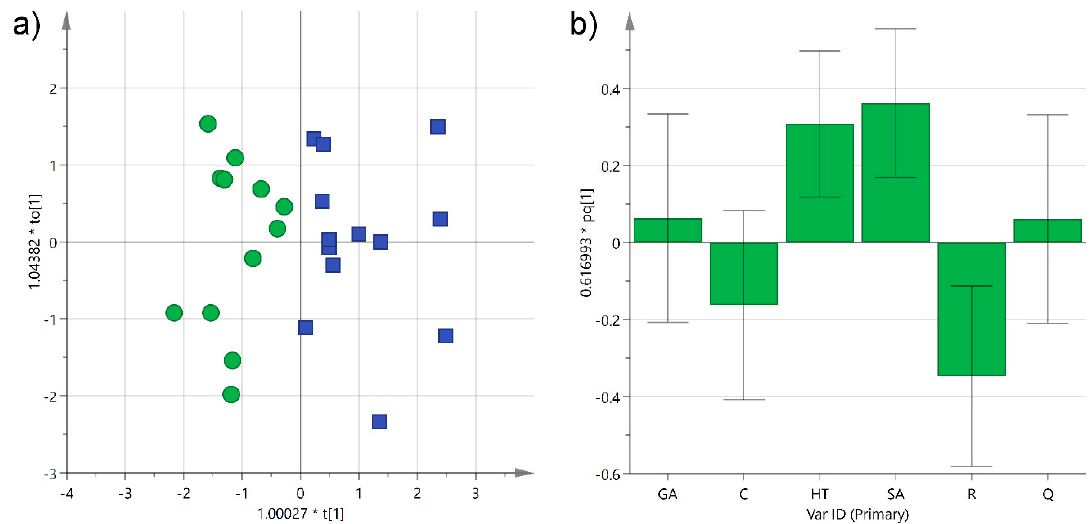
Figure 6. ( a ) Orthogonal partial least-squares discriminant analysis (OPLS-DA) score plot of PC1 ( R 2X